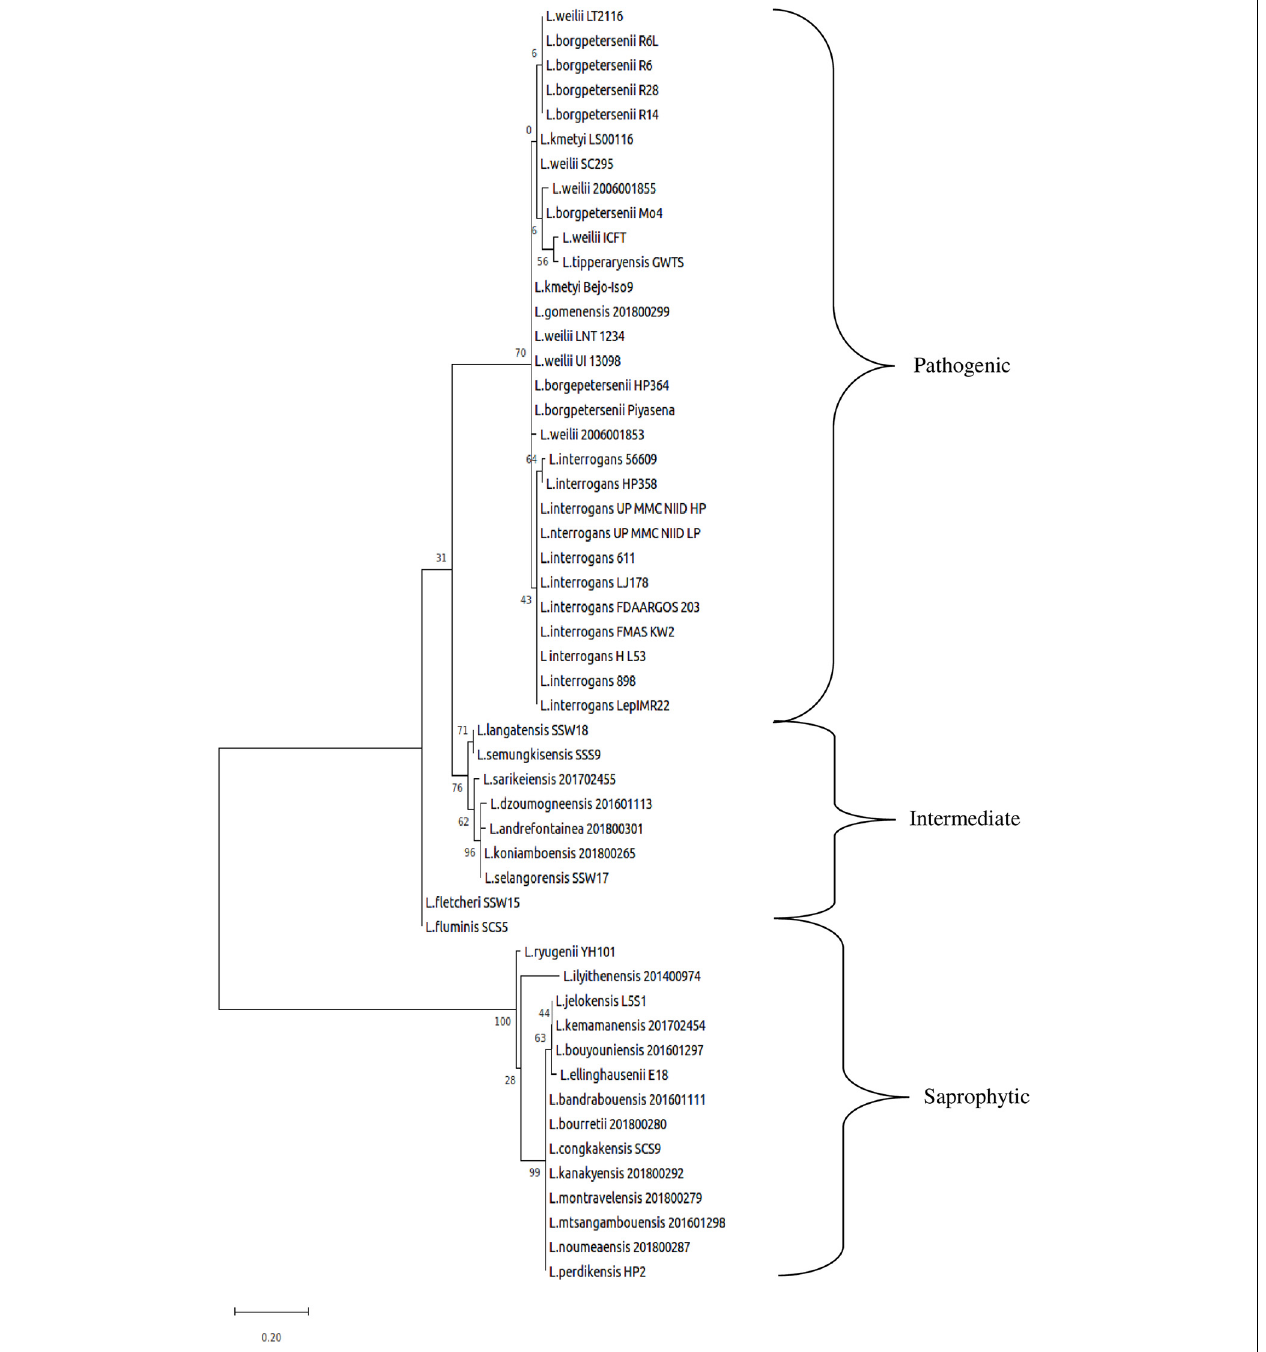
FIGURE 4 | Whole-genome core single-nucleotide polymorphisms (core SNPs) phylogeny of Leptospira isolates based on the maximum likelihood method with 1,000 bootstrap